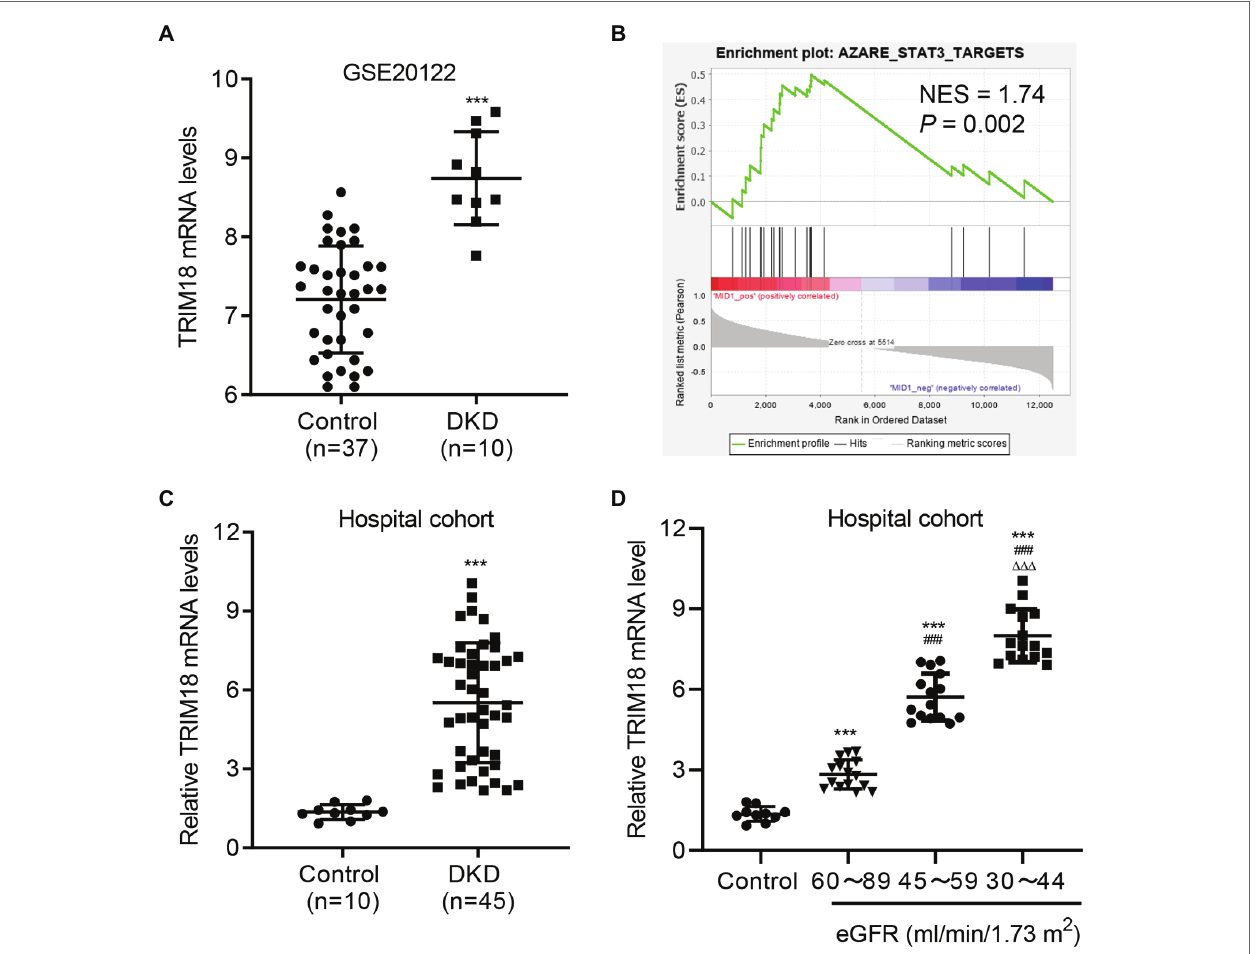
FIGURE 1 | TRIM18 expression is increased in diabetic kidney disease (DKD). (A) TRIM18 expression in renal tubulin in controls ( n = 10) and patients with DKD ( n = 45) from the GSE30122 dataset. (B) Gene set enrichment analysis (GSEA) demonstrated that the STAT3 signaling pathway is correlated to TRIM18 expression. (C) TRIM18 expression in the renal tissues of control ( n = 10) and patients with DKD ( n = 45) in the hospital cohort. (D) TRIM18 expression in renal tissues of control ( n = 10) and DKD patients with different estimated glomerular filtration rate (eGFR) levels ( n = 15 per group) in hospital cohort. Values are presented as mean ± SD. *** p < 0.001 vs. control. ### p < 0.001 vs. 60–89 eGFR. ΔΔΔ p < 0.001 vs. 45–59